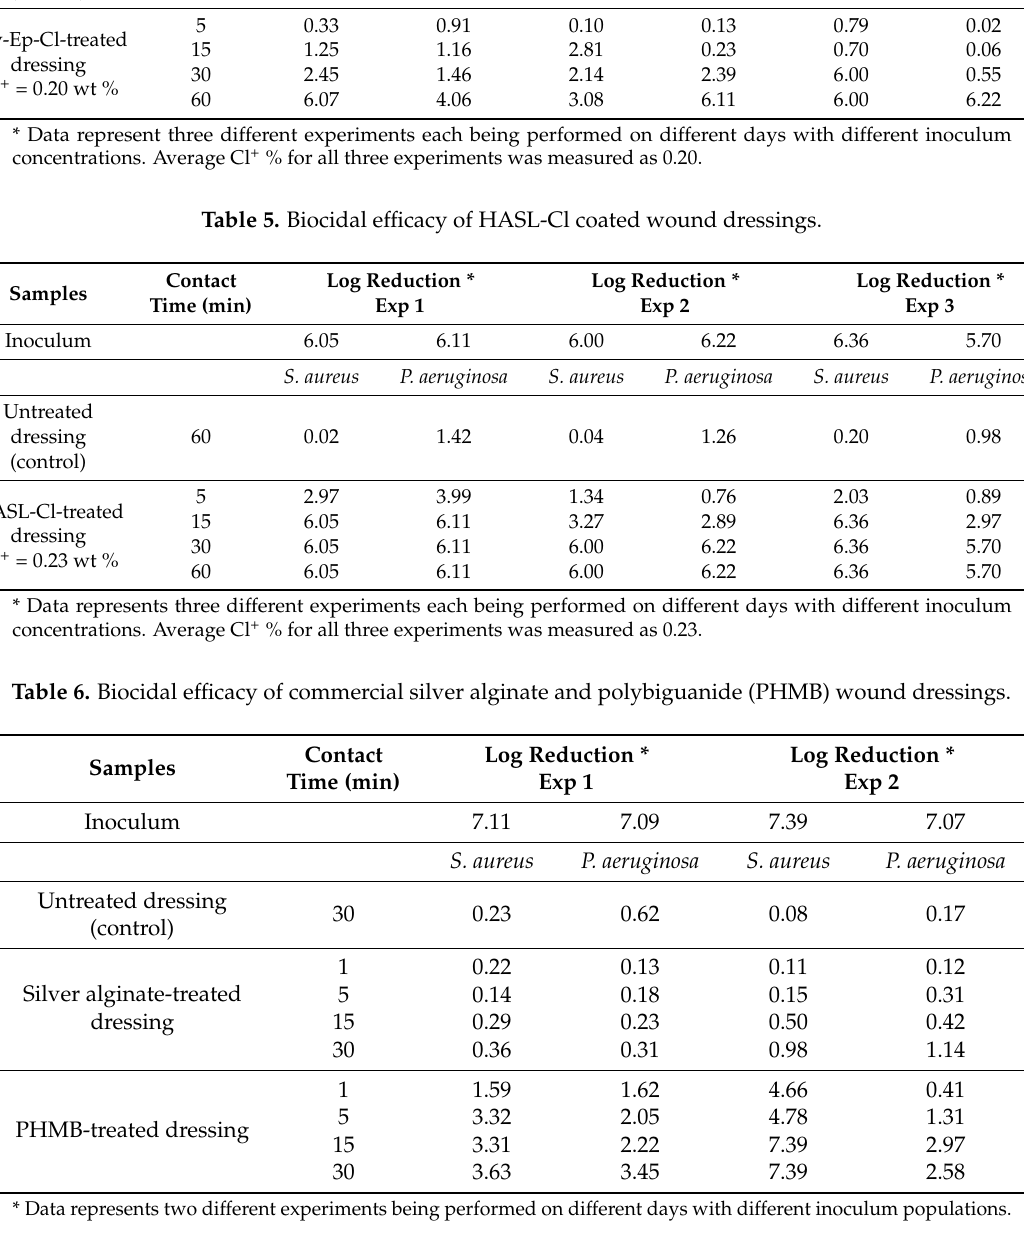
* Data represents two different experiments being performed on different days with different inoculum